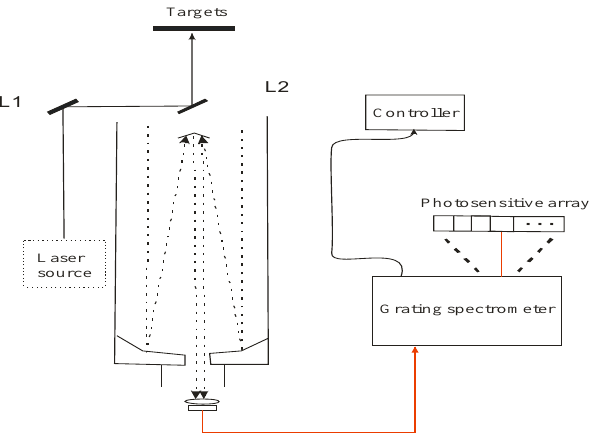
Figure 1 The optical diagram of the 32-channel HSL